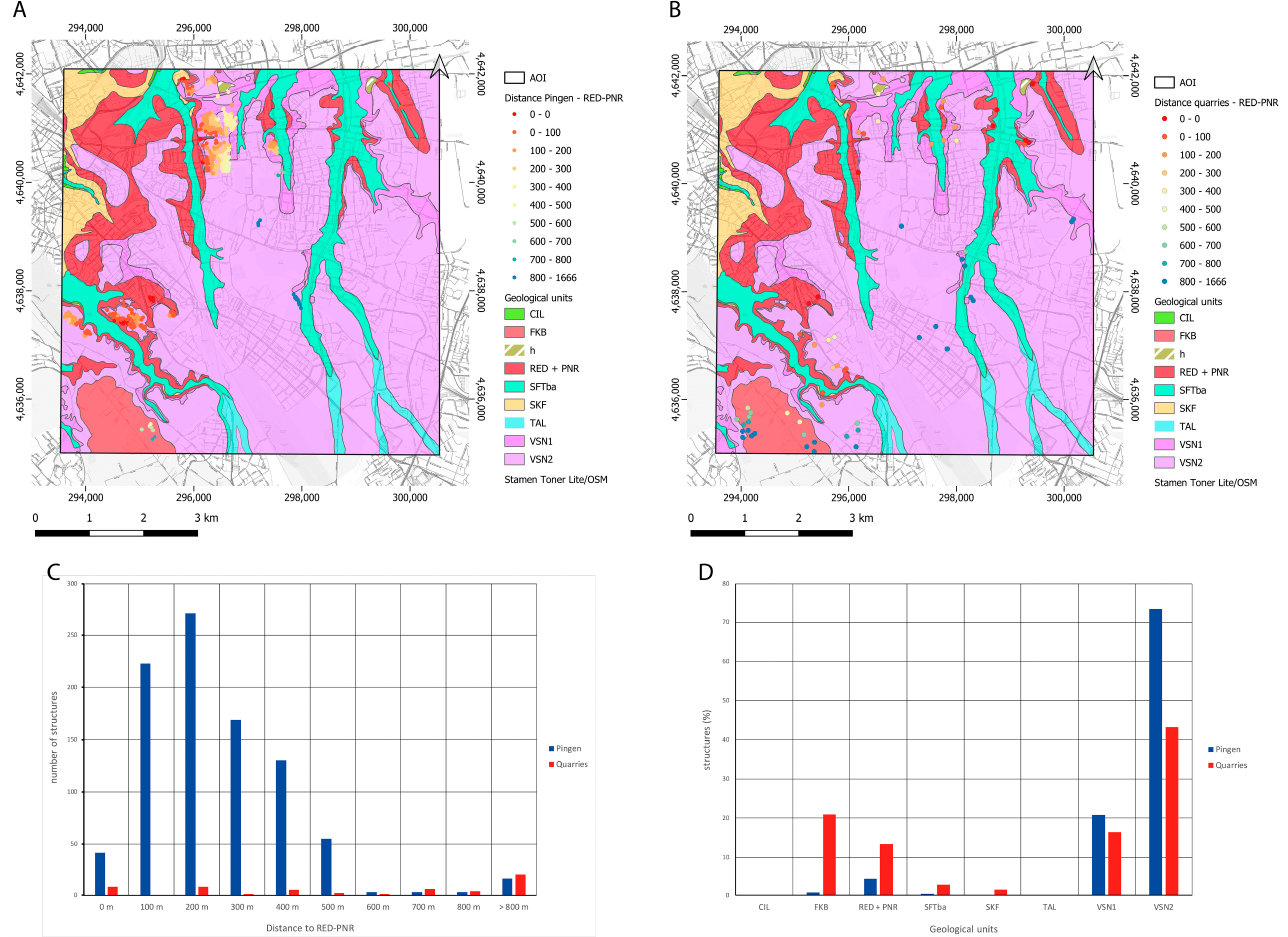
Figure 13. ( A ) Display of the vectored geological units and the pingen (centroids), classified for the distance from the RED-PNR unit; ( B ) display of the vectored geological units and the opencast quarries (centroids), classified for the distance from the RED-PNR unit; ( C ) distribution of quarries and pingen related to distance to the border of RED-PNR; ( D ) relative incidence of sinkholes and quarries related to all the geological units.